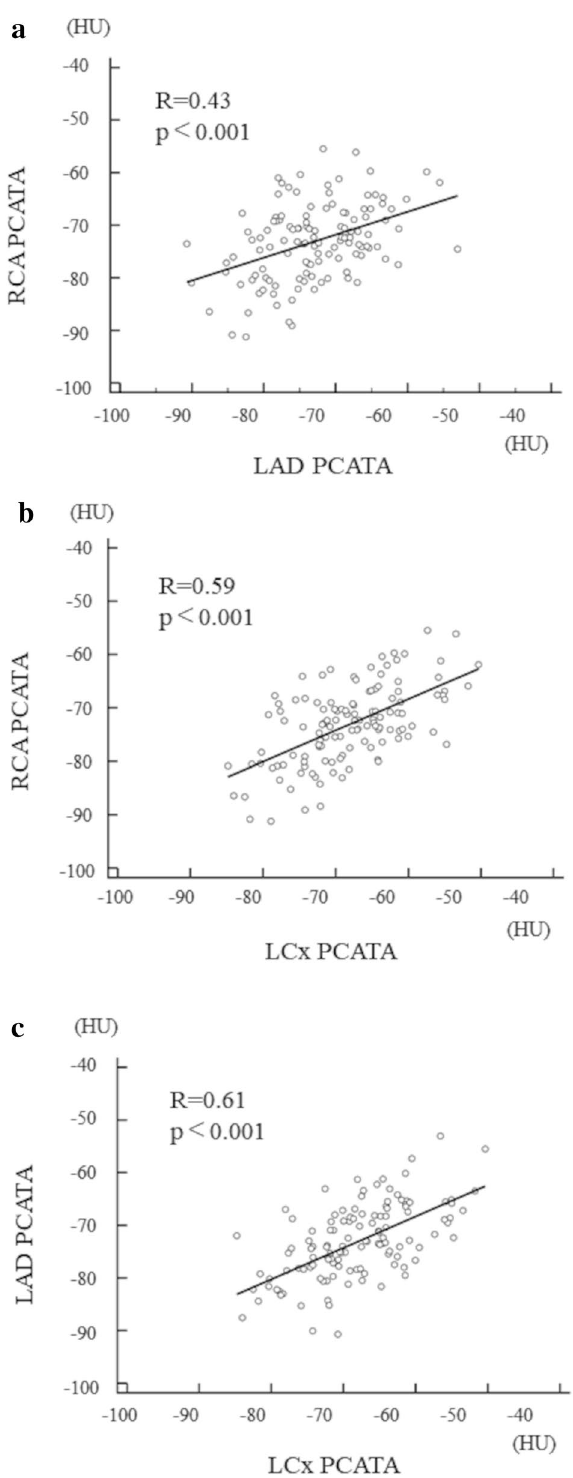
Figure 3. Association of PCATA values between the three major epicardial coronary arteries. ( a ) RCA and LAD, ( b ) RCA and LCx, and ( c ) LAD and